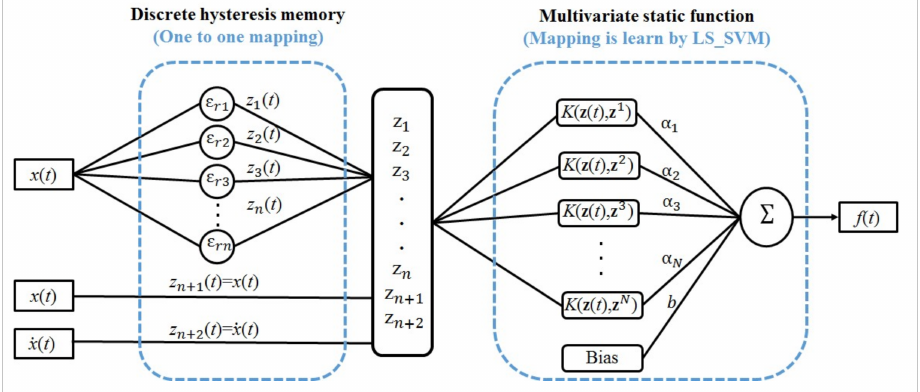
Figure 2. LS-SVM hysteresis model